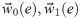
(a) Average individual exposure time without family contributions (Eq (9); weeks 17-26, working days only. Corona lockdown measures in The Netherlands started around week 13). Each line reports average data from bins w→0(e),w→1(e), etc. The inset on the left shows the average daily passenger count, Ndaily. The inset on the right reports the same individual exposure time data for week 21 in histogram form. A change in the train schedule on the 2nd of June (week 23, indicated with a vertical black dashed line) increased the train frequency by a factor γ ≈ 1.7 (Eq 14). This improved the distribution of pedestrians over the day thereby temporarily decreasing the individual exposure time. To make the data comparable over time and compensate for the train increment, we multiply the exposure times by γ, Eq (14) (dashed green line, bin w→2(e) only, i.e. r ∈ [1.0, 1.5] m ≈ D). We notice that the compensated exposure time grows steadily in time gaining a factor 3.5×. This is a combined effect of the passenger growth and a reduction in attention and/or difficulty in adhering to physical distancing regulations. In panel (b) we scale the exposure time by the number of passengers, i.e. we report γTp,fd/N (d = 2). This ratio, which we further scale to its value at week 18, displays a ≈100% growth between week 18 and 26, to confirm that the increment of passengers contributes only for 150% of the overall exposure time growth.